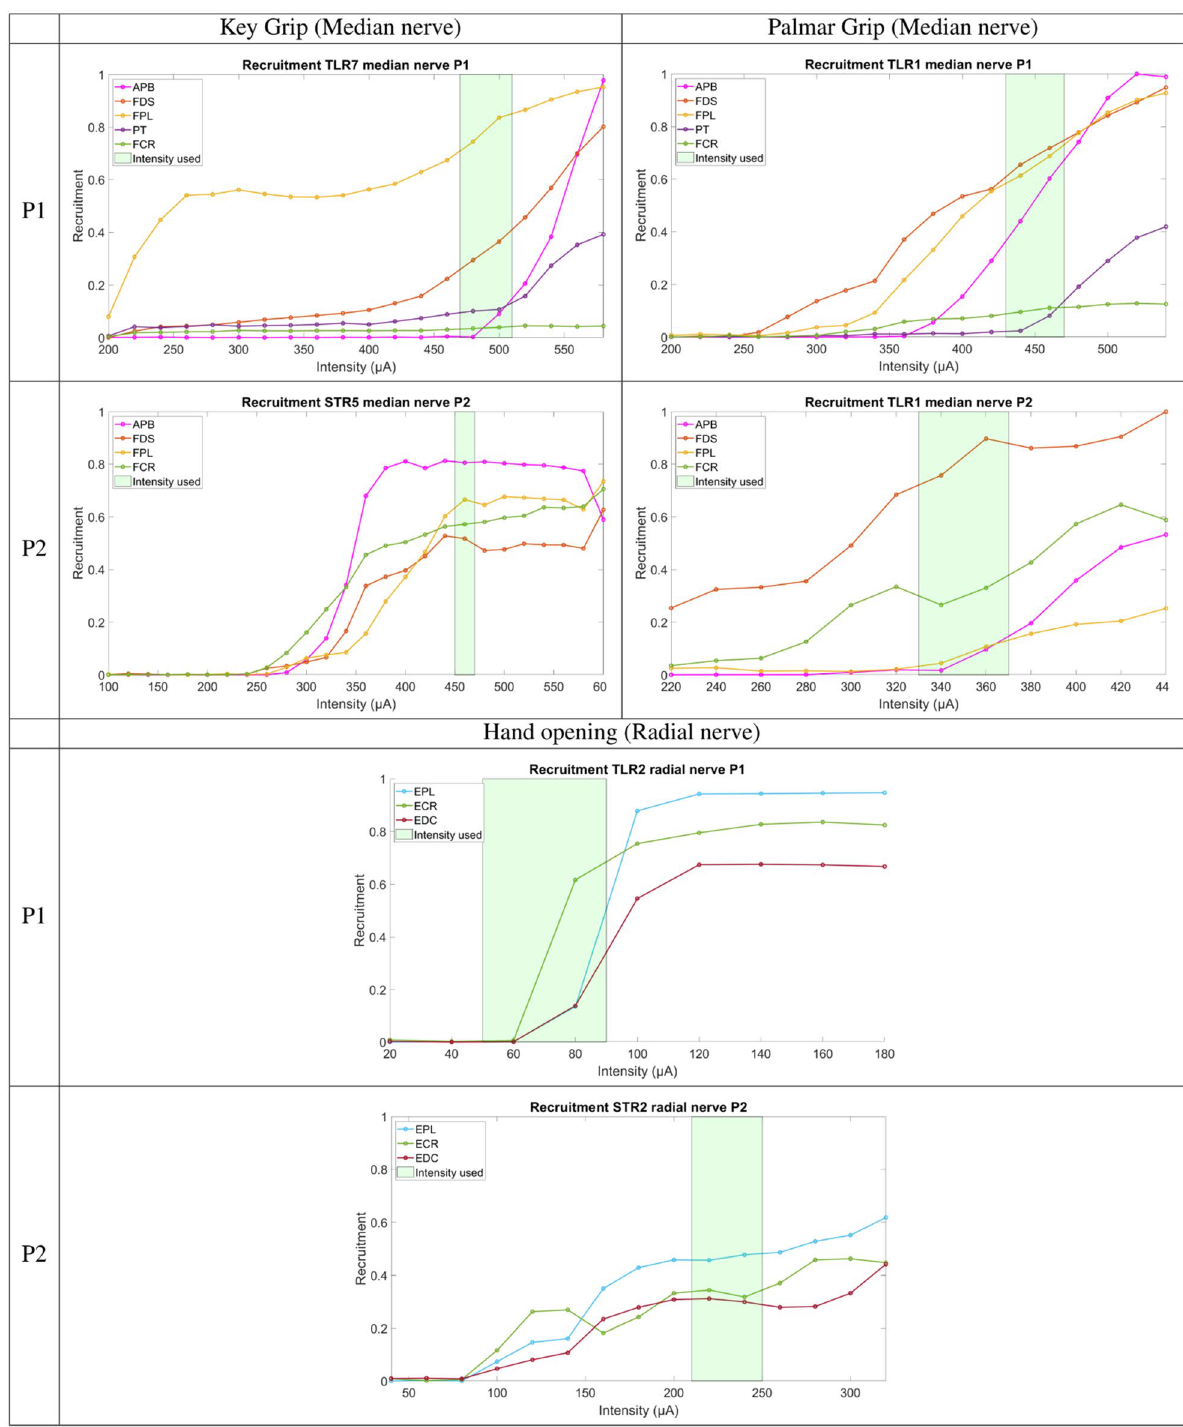
Figure 2. Recruitment curves of the 3 selected configurations evoking functional movements: Participant P1: TLR2 for hand opening (radial nerve), TLR1 for palmar grip, TLR7 for key grip (median nerve). Participant P2: STR2 for hand opening (radial nerve), TLR1 for palmar grip, STR5 for key grip (median nerve). The green areas show the ranges of usable intensity settings that allow modulating the force while keeping a similar muscles’